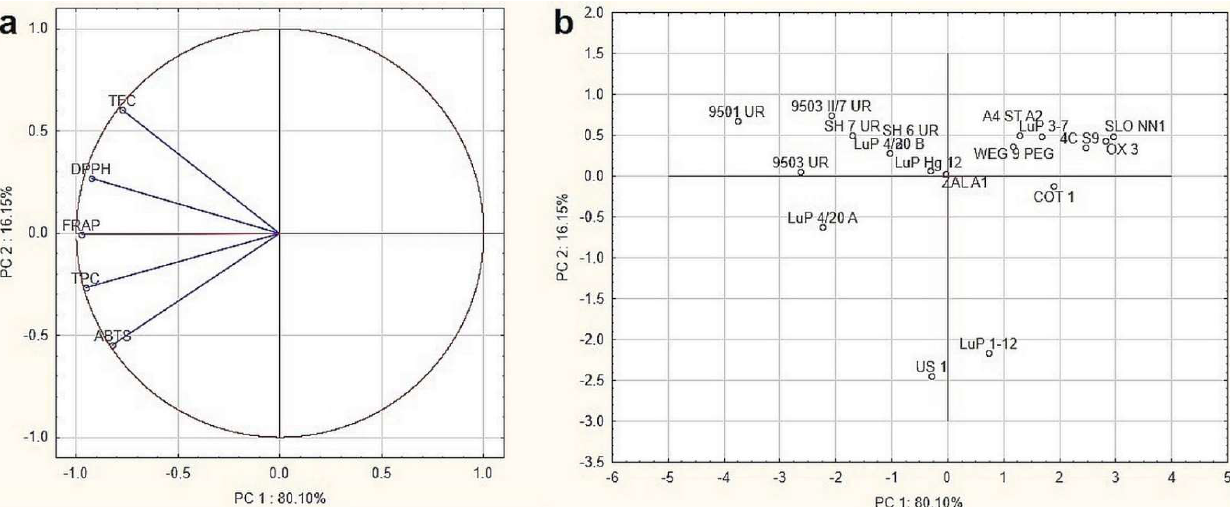
Figure 1. Statistical analysis results: ( a ) projection of chosen variables as a function of the PC1 vs. PC2, ( b ) PCA score plot of leaf blades extract. PC—principal component, TFC—total flavonoid content, TPC—total phenolic content, DPPH—(2,2-diphenyl-1-picrylhydrazyl scavenging assay, ABTS—2,2′-azino-bis(3-ethylbenzothiazoline-6-sulfonic acid antioxidant assay, FRAP—Ferric Reducing Antioxidant Power assay. For sample identification legend, see Table 1.